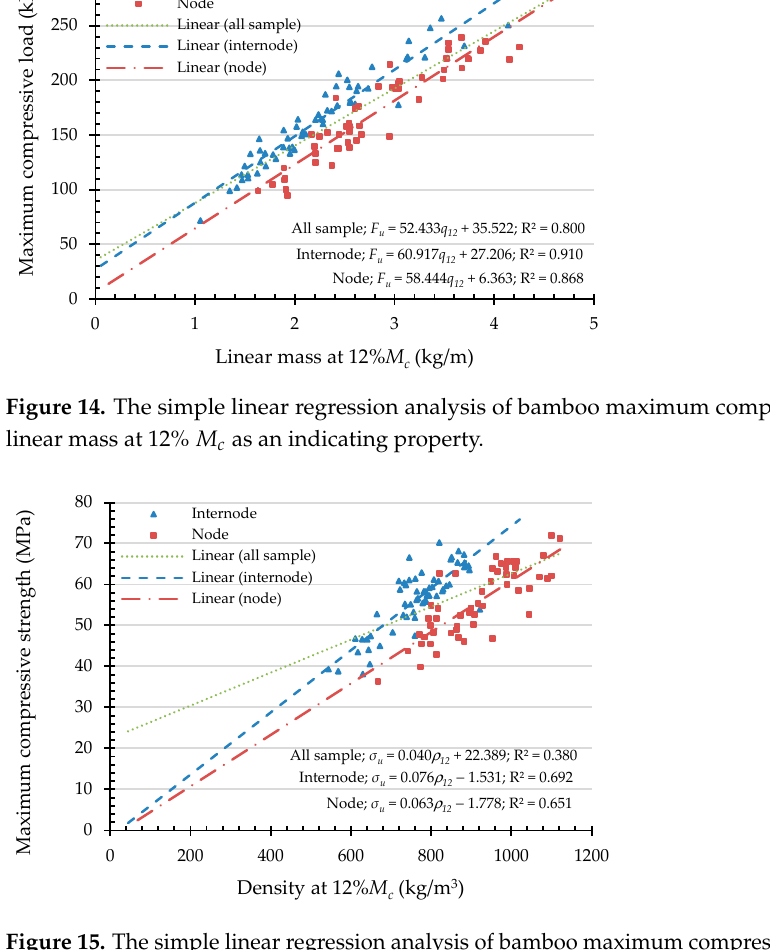
Figure 15. The simple linear regression analysis of bamboo maximum compressive strength ( σ u ) with linear mass at 12% M c as an indicating property.